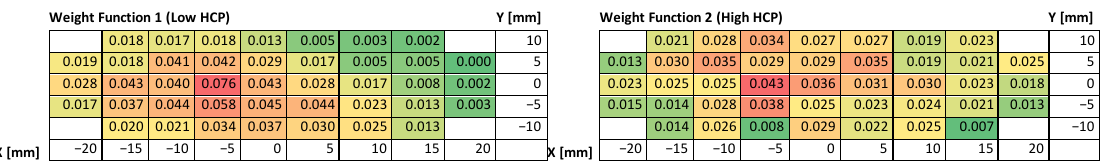
Table 2. Weight functions for high and low handicap test